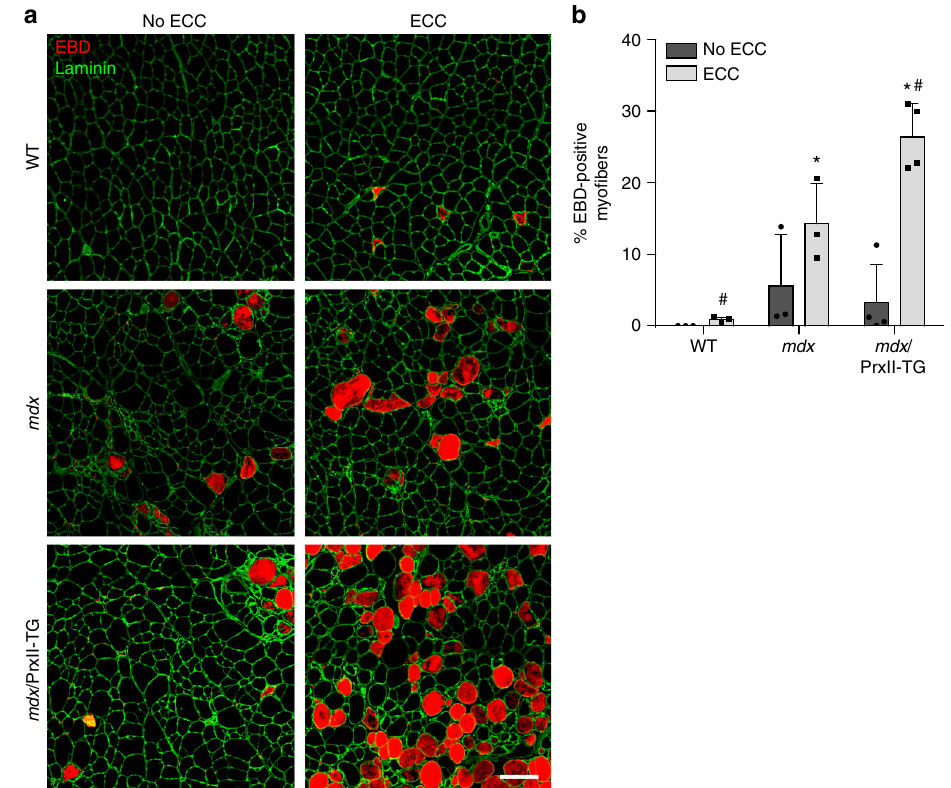
Fig. 7 Muscle-speci fi c peroxiredoxin-2 overexpression leads to increased sarcolemmal damage following long-term injurious eccentric contractions in mdx mice. a Fluorescent microscopy of WT, mdx , and mdx /PrxII-TG (58×) for Evans blue dye (EBD; red) and laminin (green). No ECC contralateral TA not subjected to eccentric contractions, ECC TA subjected to 70 eccentric contractions performed in vivo. Scale bar = 50 µ m. b Quanti fi cation of